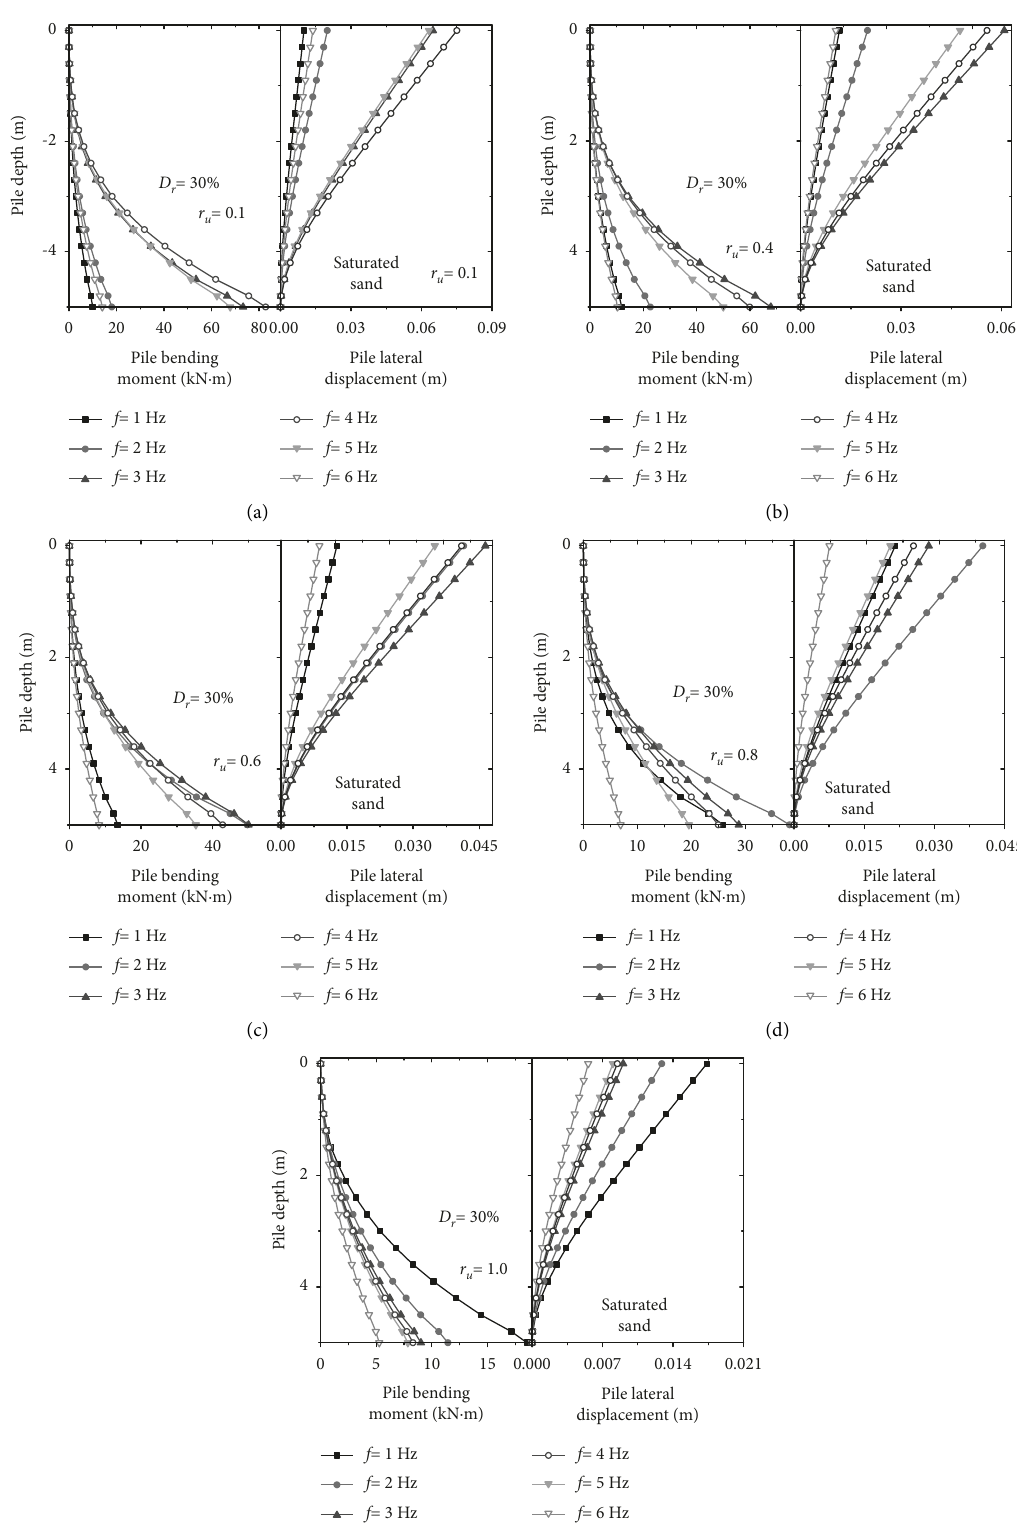
Figure 10: Bending moment and lateral displacement of pile under different loading f : (a) r (e) r u (cid:31)